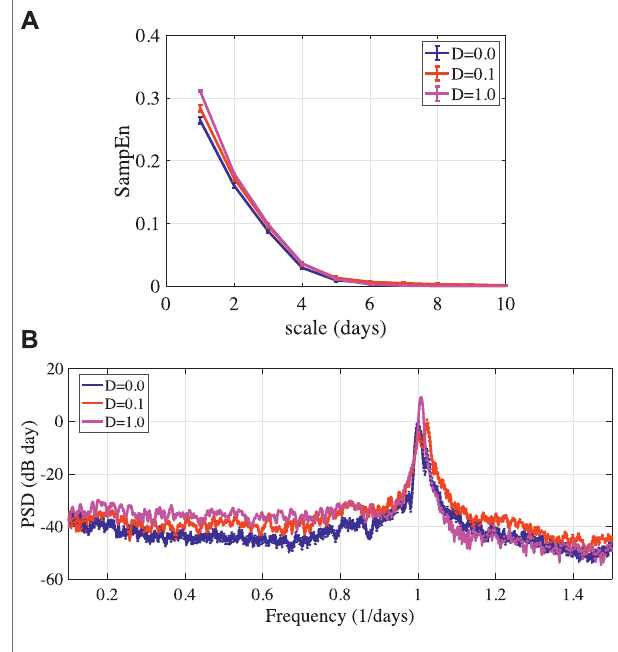
FIGURE6|(A) MSEanalysisofcircadianrhythmsoutput( k )givenby Eq. (11) in stabilized BD ( A (cid:1) 15 . 0 , K (cid:1) 0 . 5 , D (cid:1) 0) case and cases under the in fl uence of stochastic noise D ξ ( n )( D (cid:1) 0 . 1 , 1 . 0 ) cases. The mean and standard error of SampEn in 10 trials are shown by solid line and error bar respectively. (B) PSD of circadian rhythm output( k ) in BD and stabilized cases. The mean and standard error of PSD were indicated by solid and dottedlines,respectively.InMSEanalysis,theSampEninthescale( ( 5 days) under the noise ( D (cid:1) 0 . 1 , 1 . 0) increases in comparison with noise-free condition ( D (cid:1) 0 . 0). In power spectrum analysis, both lower and higher frequency component of PSD around peak ( ≈ 1 . 0 [1/day]) increases in D (cid:1) 0 . 1 case. In stronger noise strength condition ( D (cid:1) 1 . 0), the lower frequency component of PSD ( ( 1.0 [1/day])